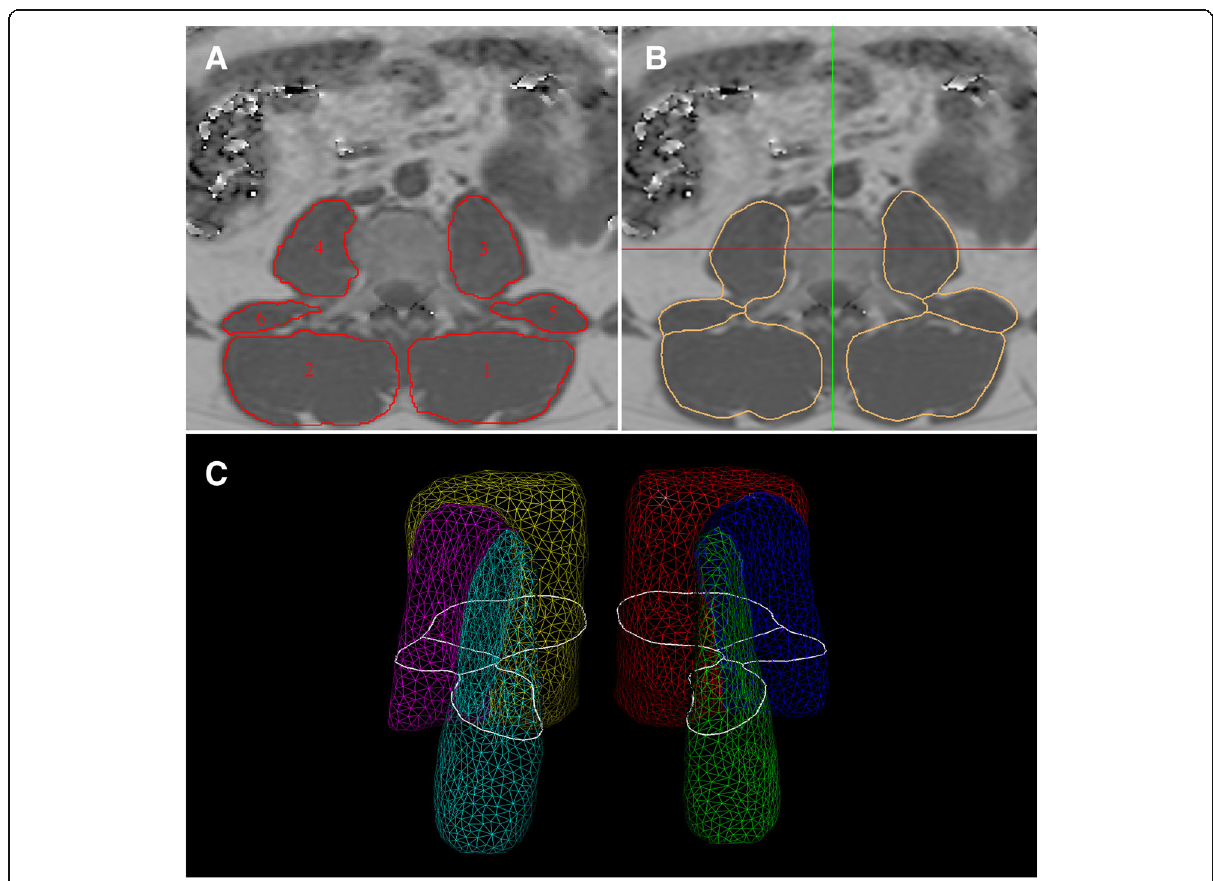
Fig. 1 Representative PDFF maps . a Manually segmented muscle compartments as ground truth: 1, left erector spinae muscle; 2, right erector spine muscle; 3, left psoas muscle; 4, right psoas muscle; 5, left quadratus lumborum muscle; 6, right quadratus lumborum muscle. b Results of the automatic segmentation of the muscle compartments. c Average triangular surface model with cross-sectional cut-contour of central axial slice depicted in